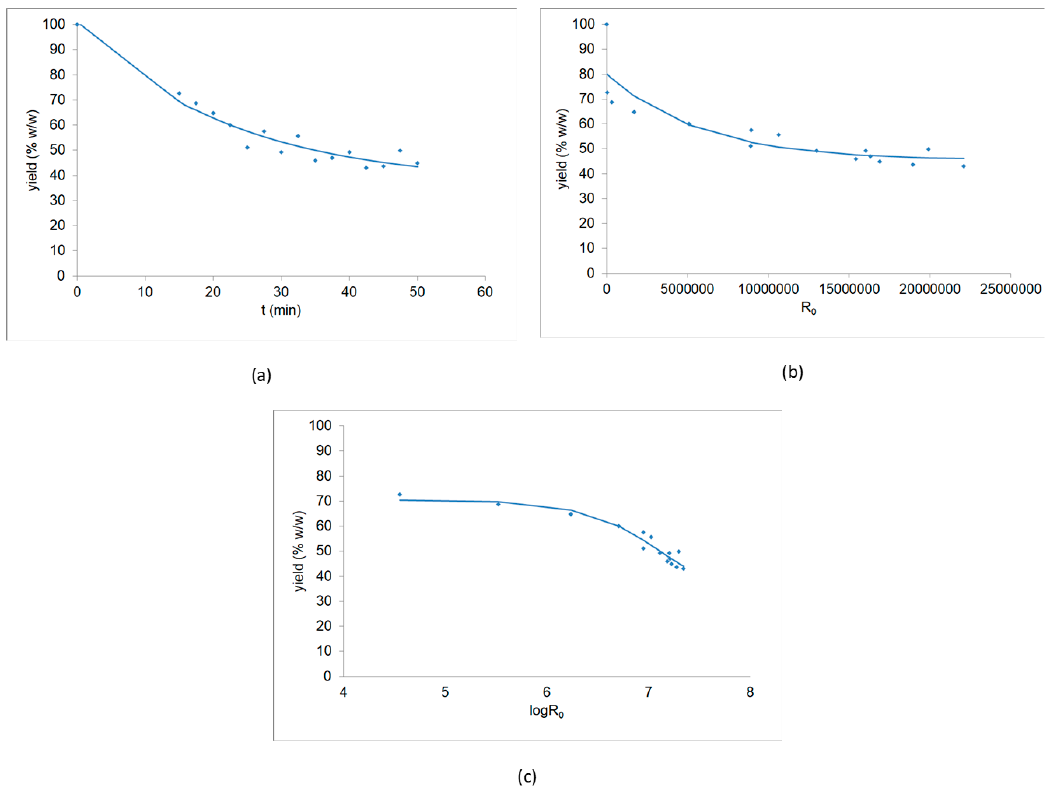
Figure 4. Torrefied barley straw solid residue yield vs. time ( a ), severity factor ( b ), and logarithm of severity factor ( c ).